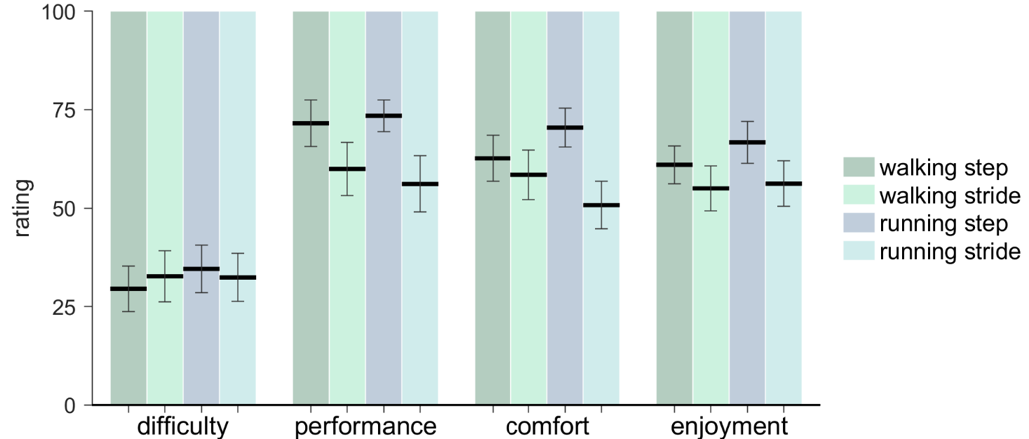
Figure 9. The mean and standard error of the ratings for perceived difficulty, performance, comfort and enjoyment for walking and running with step-based and stride-based pacing. On the scale, a low rating means low perceived difficulty/performance/comfort/enjoyment.